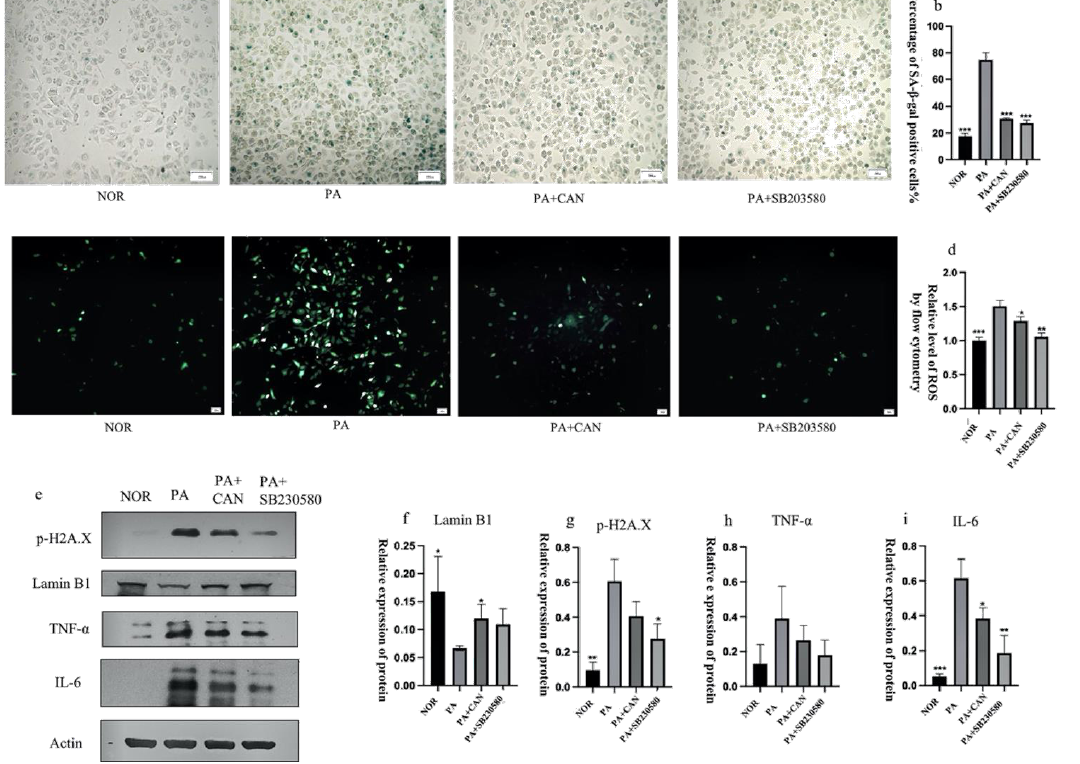
Figure 7. Inhibition of p38 protein activation delayed the senescence of HUVECs. ( a , b ) Both CAN (5 µg/mL) and SB230580 (10 µM) reduced the number of β - galactosidase staining - positive cells. ( c ) Both CAN (5 µg/mL) and SB230580 (10 µM) reduced senescence - induced intracellular ROS eleva- tion. ( d ) Results of ROS quantification using flow cytometry. ( e – i ) Both CAN (5 µg/mL) and SB230580 (10 µM) reduced the expression of the senescence - related protein p - H2A.X and increased the expression of lamin B1, TNF - α and IL - 6 in the SASP. Data are expressed as the means ± SD ( n = 3); * p < 0.05, ** p < 0.01, *** p < 0.001 vs. PA. All images are magnified to 100× .